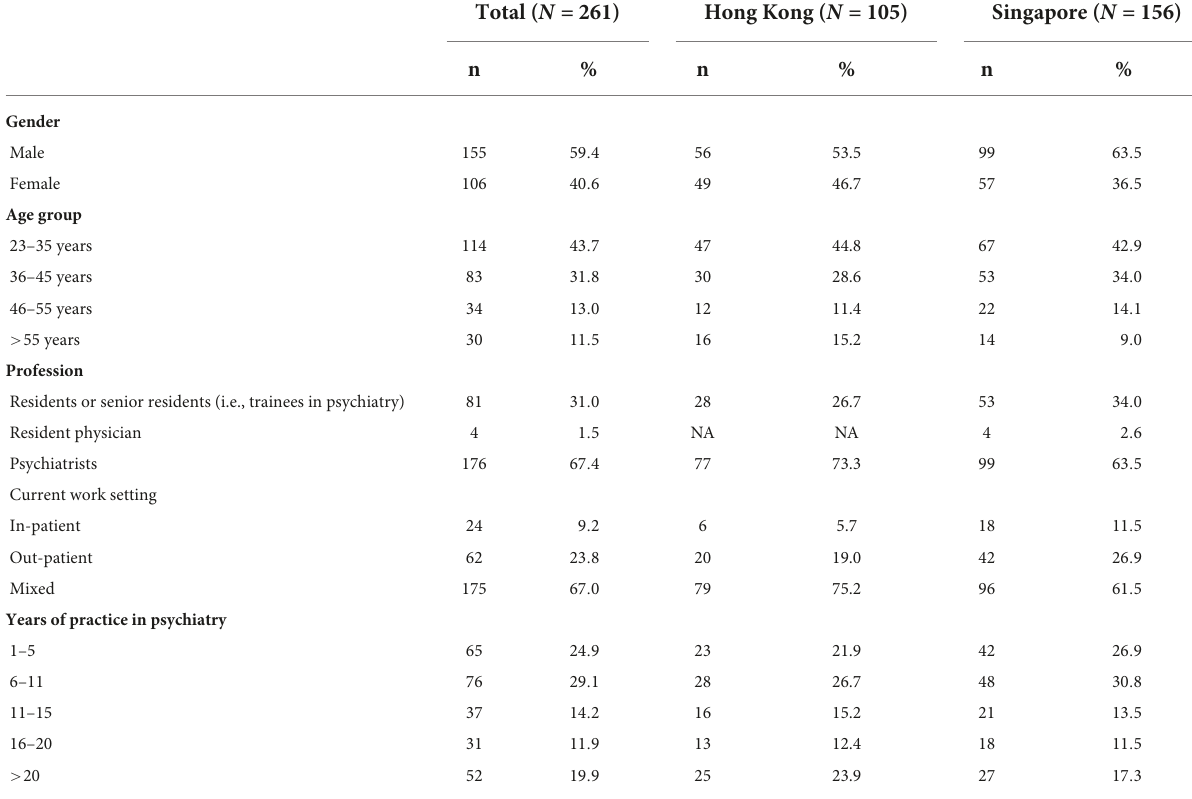
TABLE 1 Demographics of